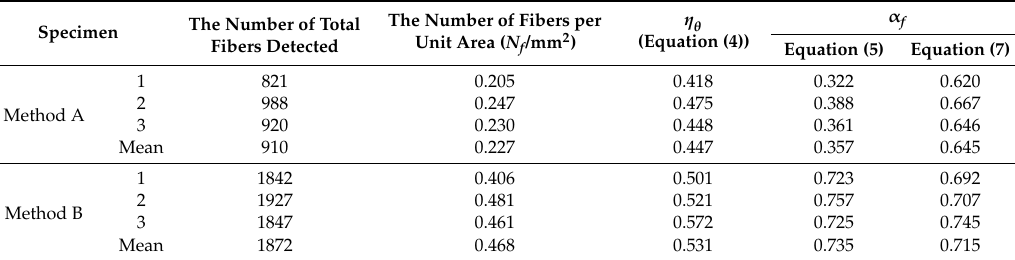
Table 4. Image analysis results for the fiber distribution.